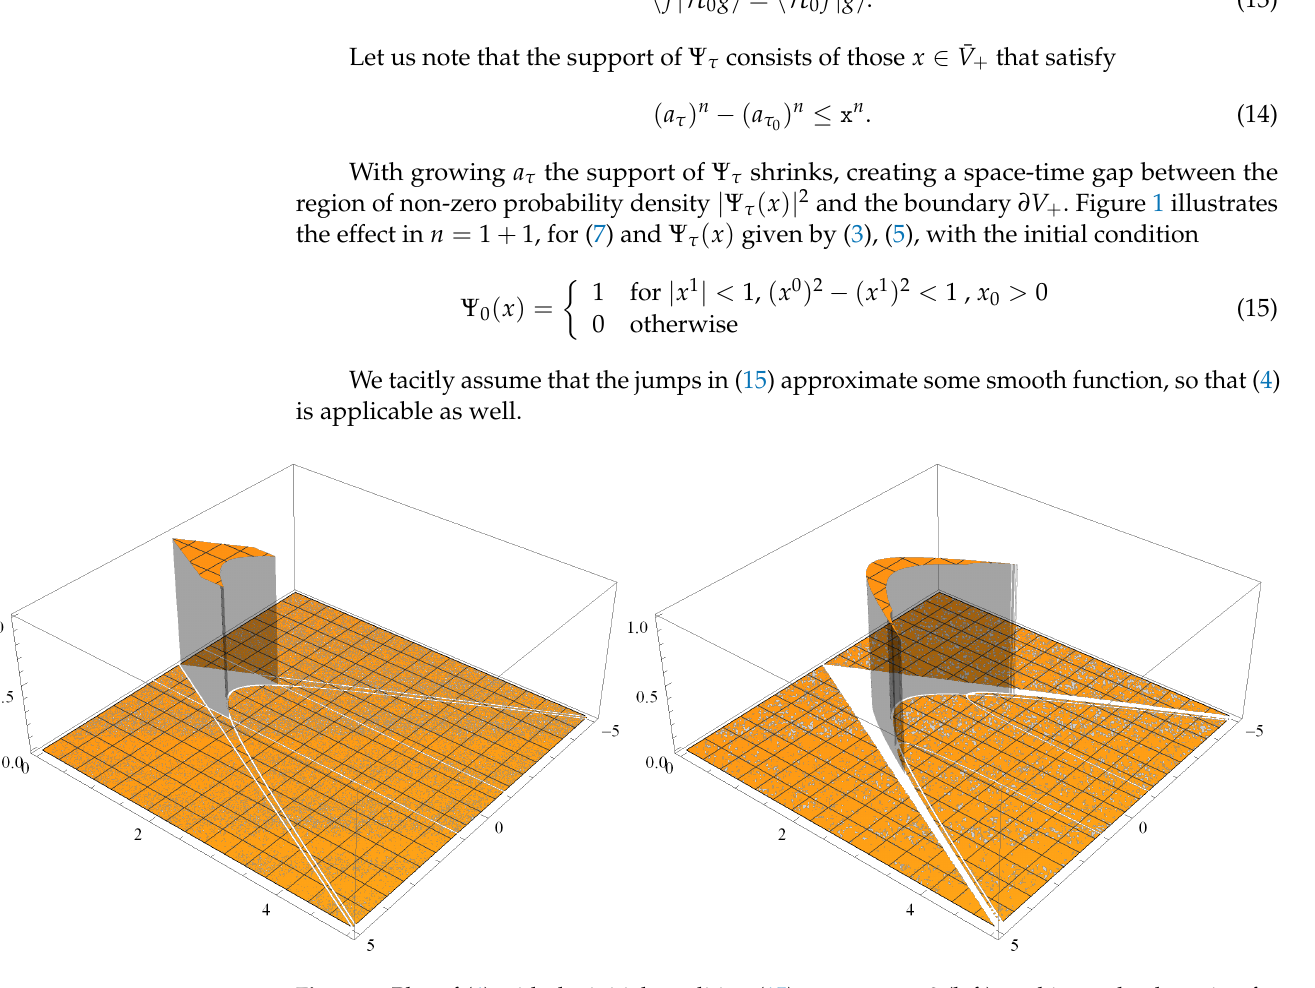
Figure 1. Plot of (4) with the initial condition (15) at τ = τ 0 = 0 (left), and its evolved version for τ = 1 (right) in a two-dimensional Minkowski space, in units where (cid:96) = 1. Ψ τ ( x ) at τ = 1 is thinner and wider than Ψ τ ( x ) at τ = 0. A space-time gap occurs between the support of Ψ 1 ( x ) and the light cone. In 1 + 3 dimensions the hyperboloid that determines the gap is given by (cid:96) 2 contrast with c 2 t 2 − x 2 ∼ τ 2 as one might naively